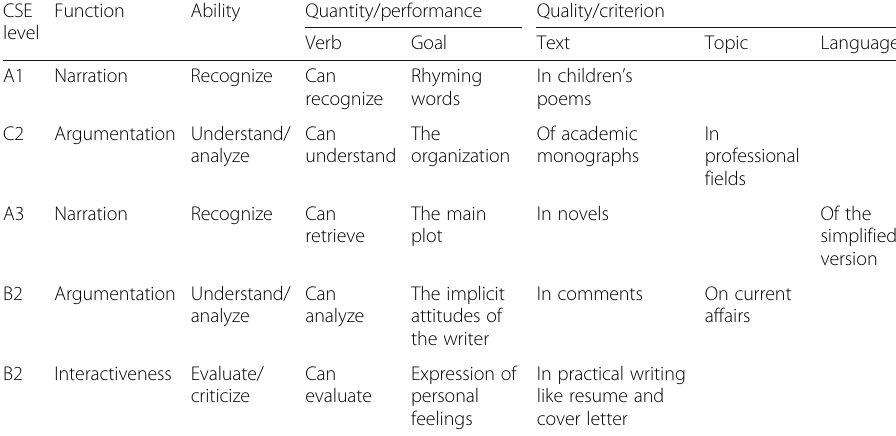
Table 5 Revised parameters of reading descriptor: cognitive ability CSE Function level